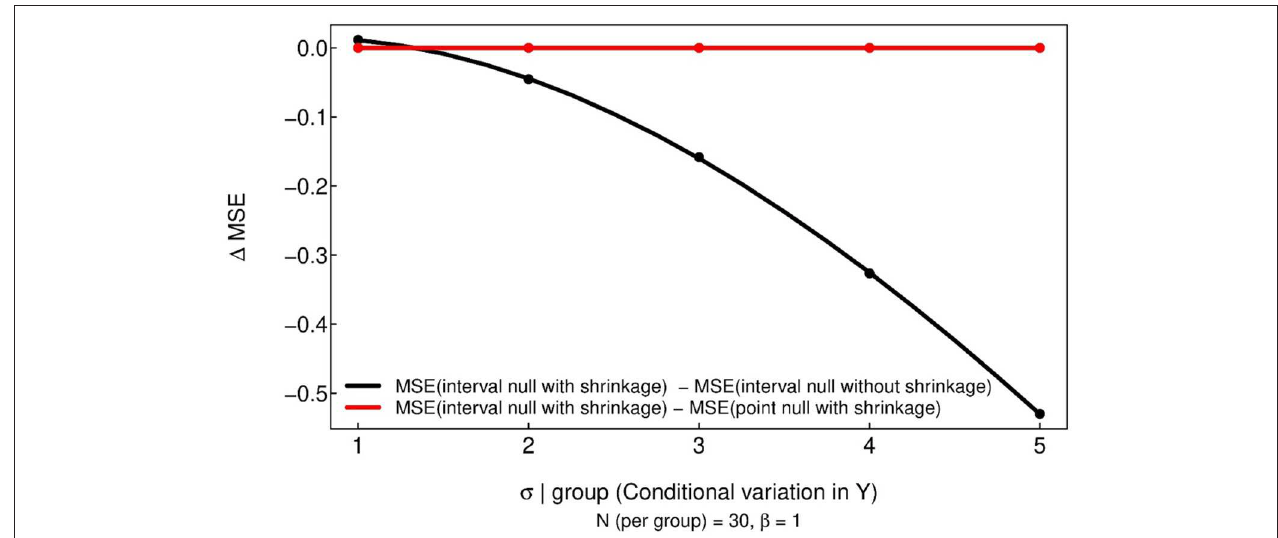
FIGURE 7 | Simulation results showing that MSE is not altered when using a point null or a region null (red line). The black line is a reference to show the change in MSE when incorporating